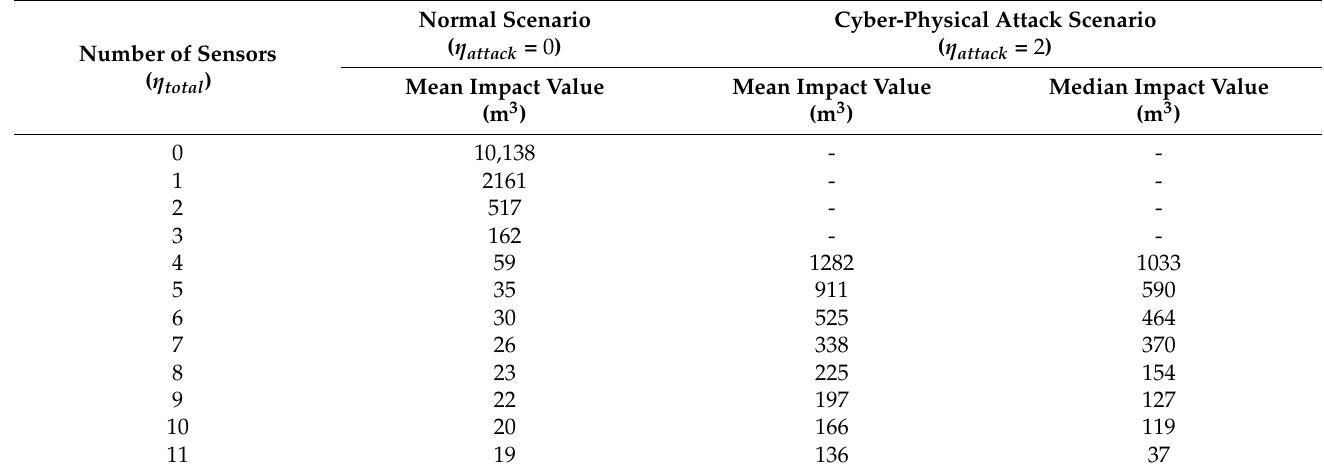
Table 1. Impact values obtained with and without cyber-physical attack of WQ